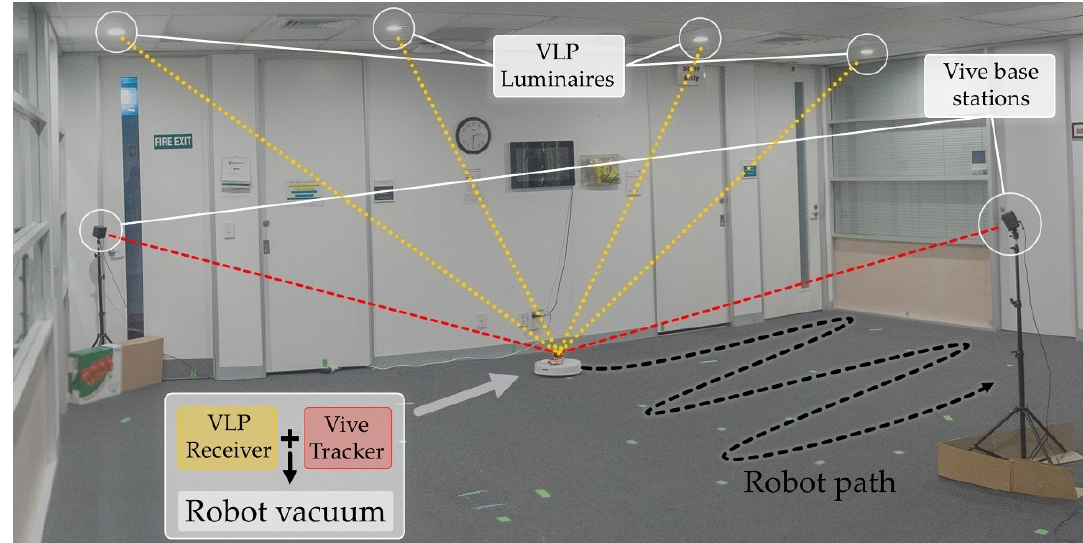
Figure 1. Office lobby used for the experiment. Two Vive base stations provide accurate positioning for the Vive tracker, which is co-located with the VLP receiver on a mobile robot vacuum.